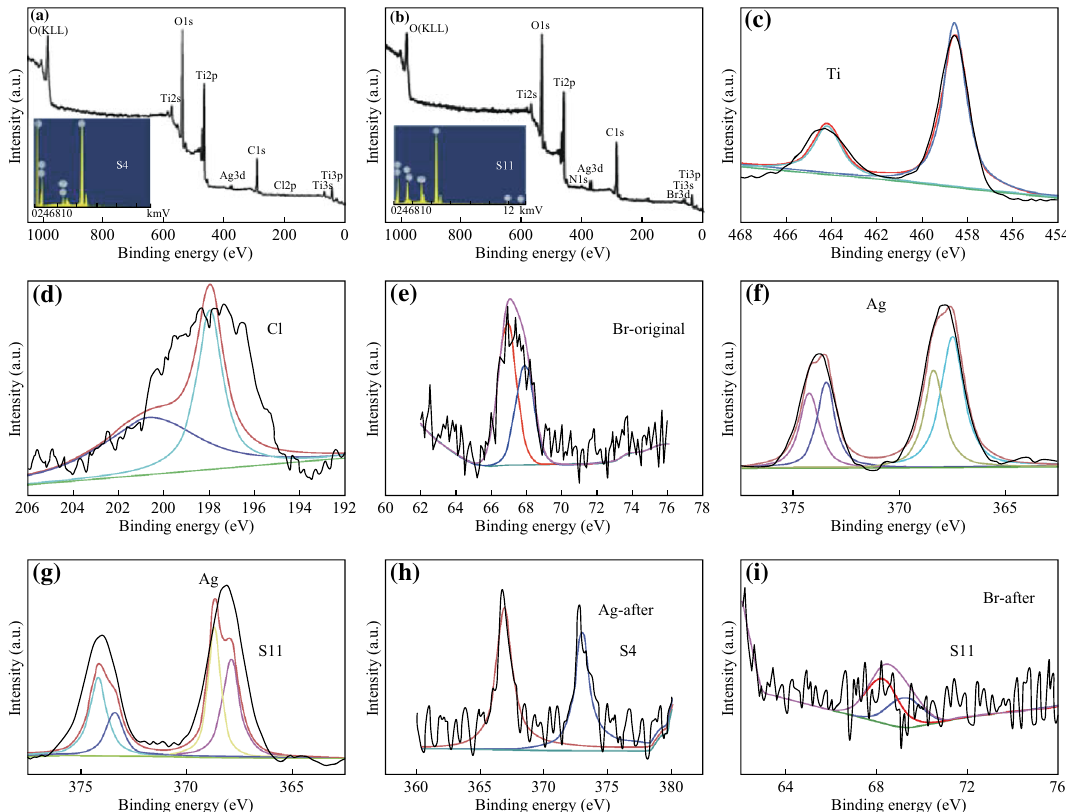
Fig. 4 XPS patterns of sample S4. Wide survey scan for a Ag–AgCl@TiO 2 and b Ag–AgBr@TiO 2 , c Ti 2 p , d Cl 2 p , e Br 3 p , f Ag 3 d and g Ag 3 d of sample S11, h Ag 3 d in S4 and i Br 3 p in S11 after 5 cycles of photocatalytic degradation. The inset EDS patterns of samples 4 and 11 are in the inset in ( a , b